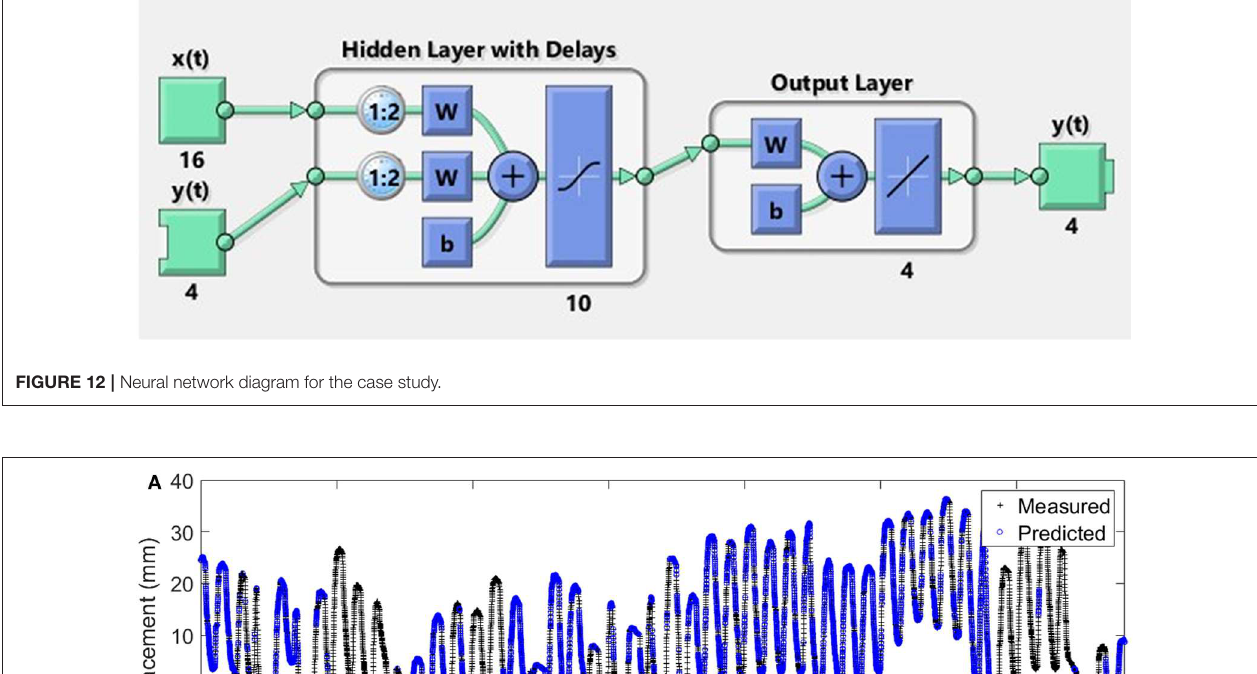
Frontiers in Built Environment |